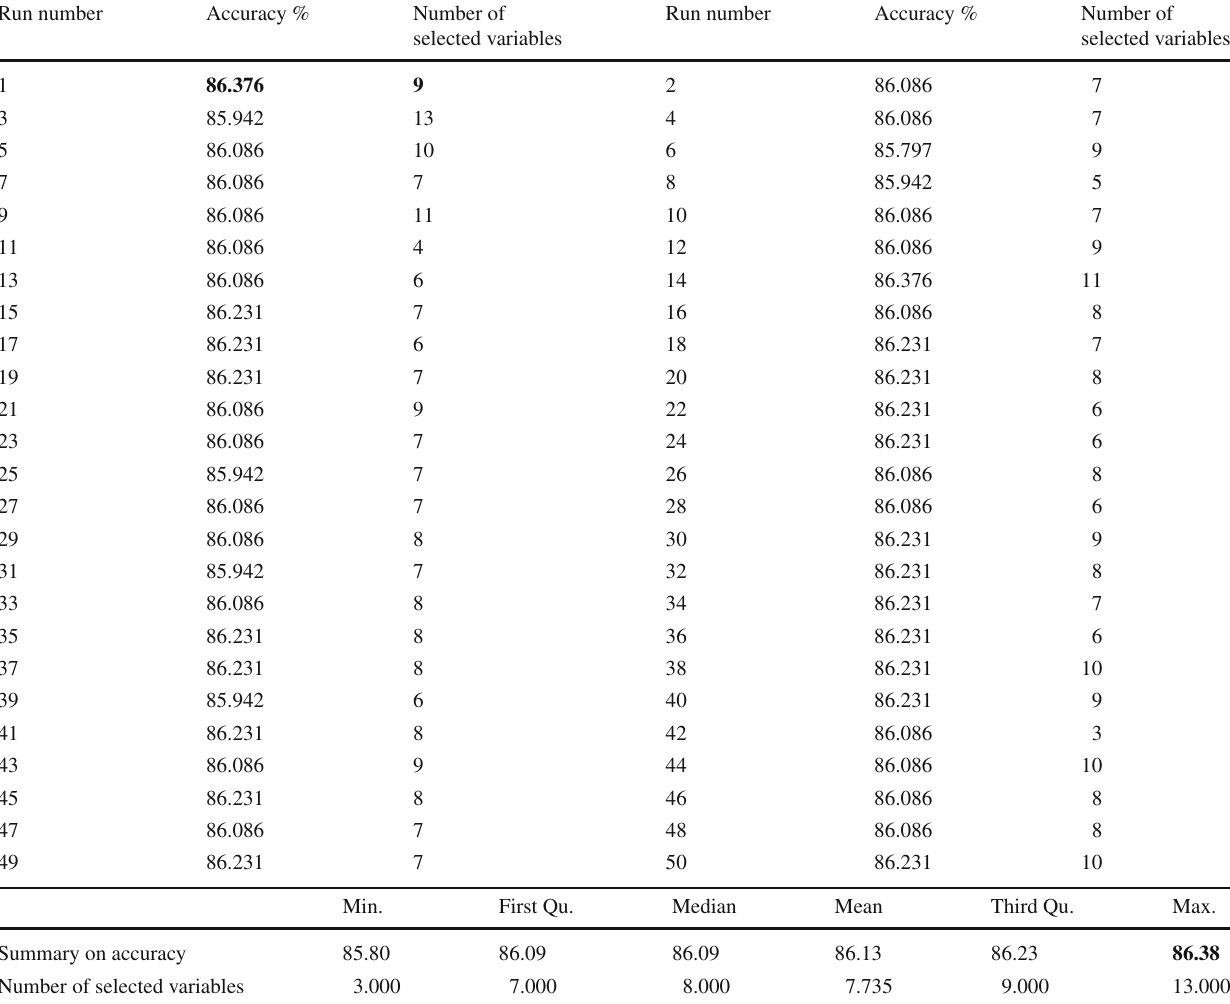
Table 4 The results of 50 run of LS+SVM on Australian